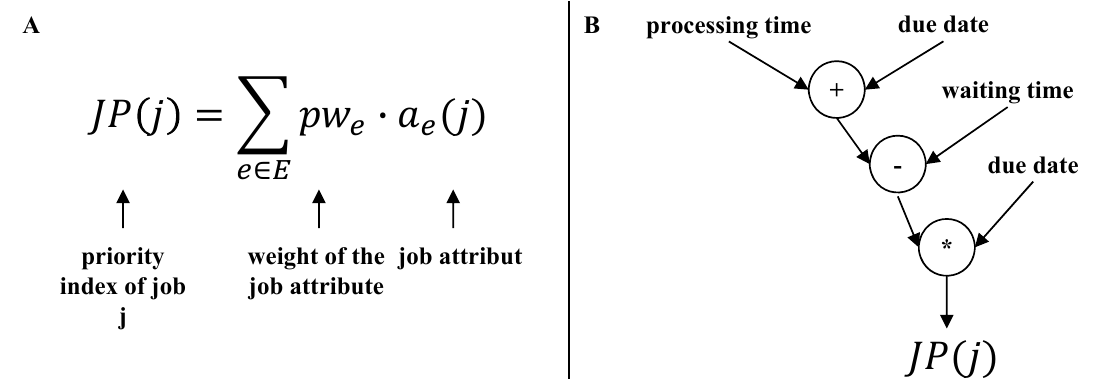
Figure 2. Combined Priority Rules (CPRs): ( A ) parameter-based representation and ( B ) grammar-based